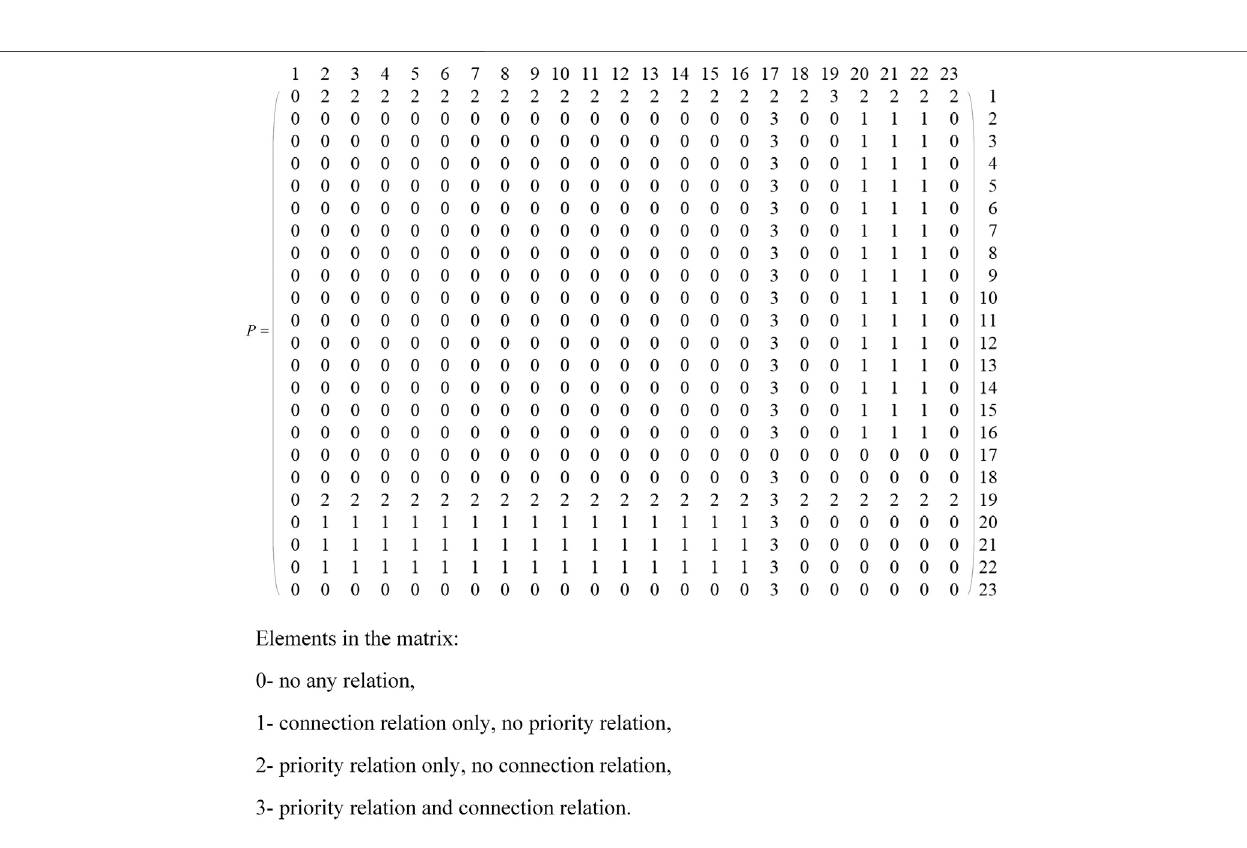
FIGURE 9 | Disassembly relation matrix of components in the